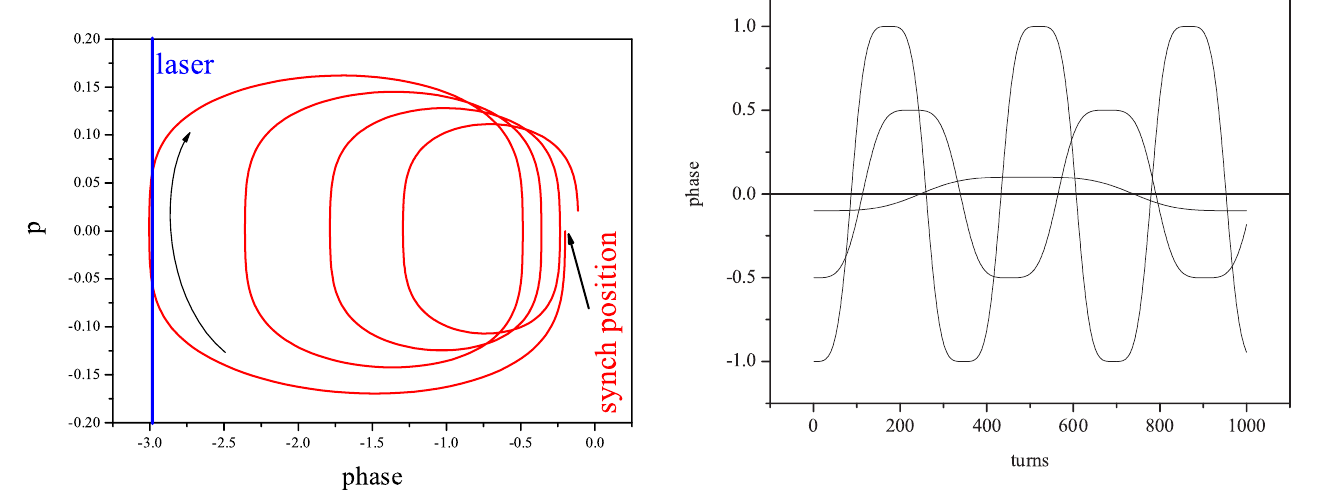
FIG. 3. (Color) Trajectory of the bunch centroid in RFPM mode (phase origin at zero of initial rf phase).